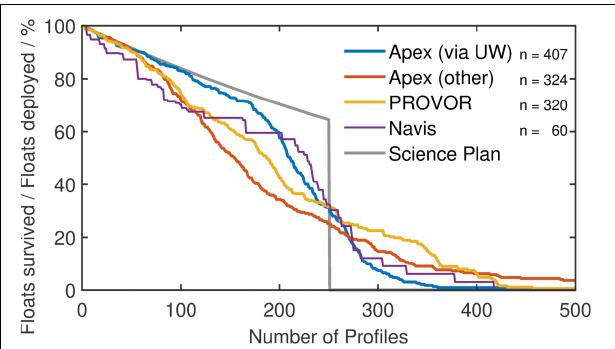
FIGURE 2 | Float survival rate of Apex-UW (blue, n = 407) vs. other Apex floats (red, n = 324). Same for Provor floats (all types) (yellow, n = 320). Note that not all of the Provor profiles go down to 2000 dbar. Navis floats (both NAVIS_A and NAVIS_EBR models) are shown for completeness (purple, n = 60). About one third of the Navis floats underwent additional checking at UW. The gray line gives the float survival estimate from the BGC-Argo Science and Implementation Plan (250 cycle lifetime, average 6 days cycle interval, 90% survival rate per year; Biogeochemical-Argo Planning Group,